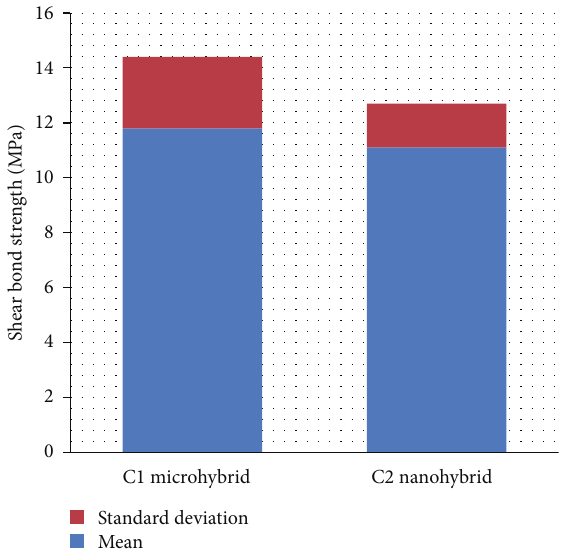
Figure 5: The effect of the composite type on the shear bond strength values.